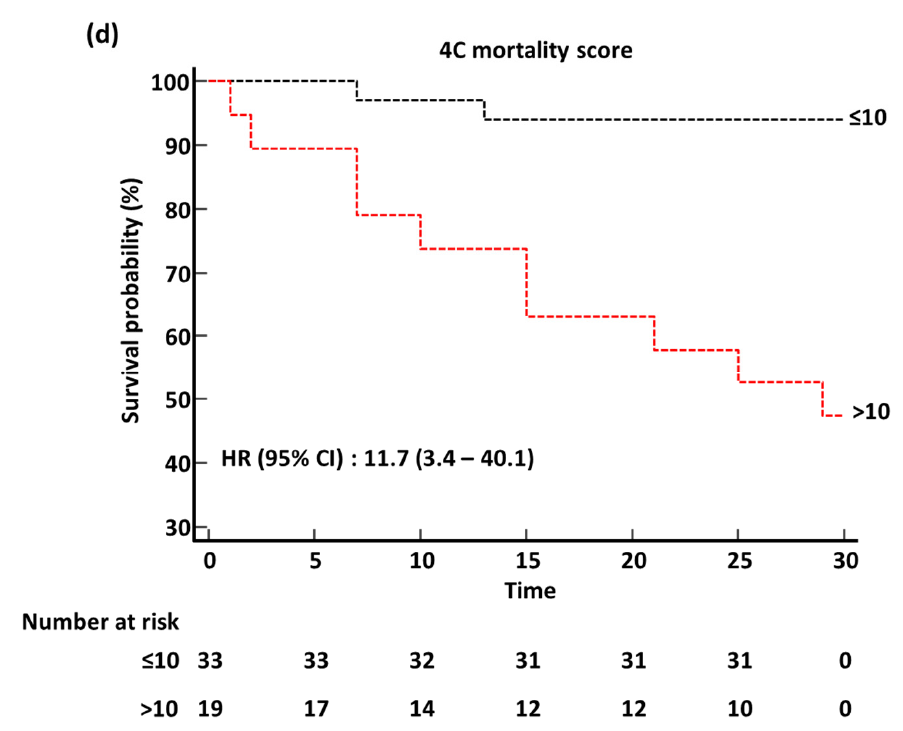
Figure 3. Kaplan–Meier survival analysis of sST2, SOFA score, critical disease, and 4C mortality score for 30-day mortality. ( a ) sST2. ( b ) SOFA score. ( c ) Critical disease. ( d ) 4C mortality score. Abbreviations: sST2, soluble suppressor of tumorigenicity 2; SOFA, sequential organ failure assessment; HR, hazard ratio; CI, confidence interval.